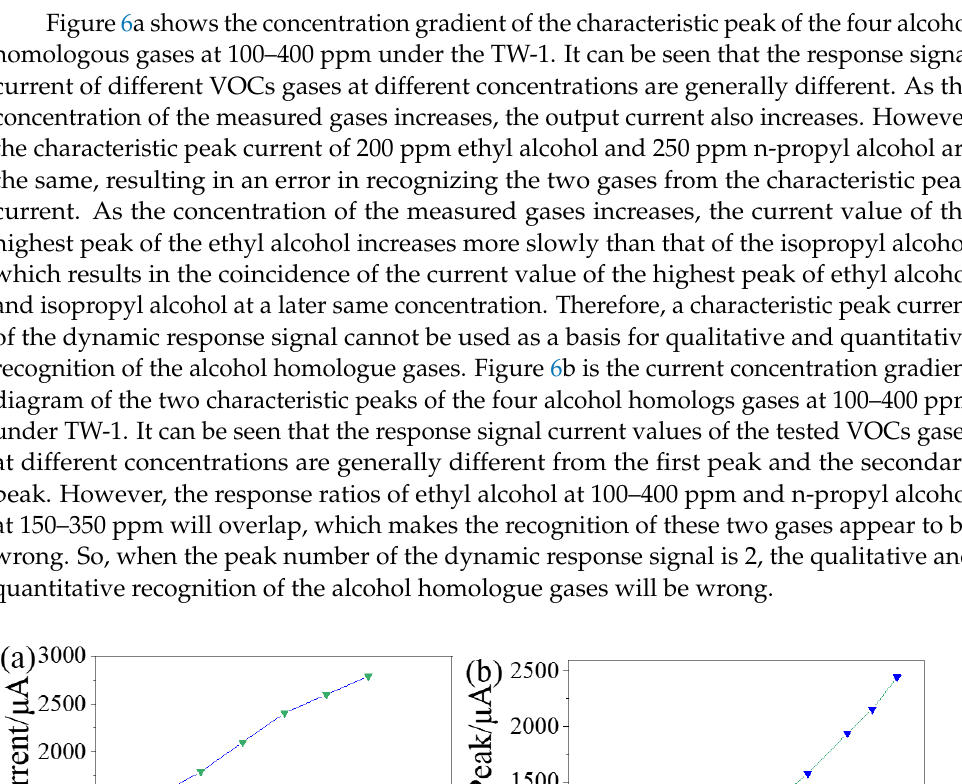
Figure 5. ( a ) The plots of Zn and O elements at different positions ( b ) three different positions of electron image.